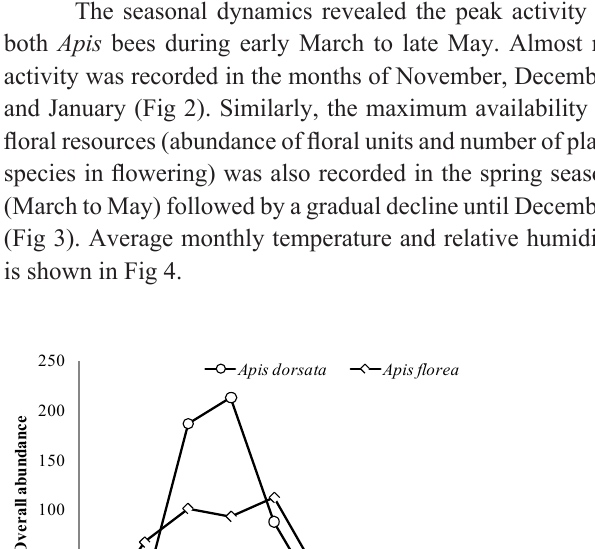
Fig 2 . Monthly abundance of A. dorsata and A. florea at Bahauddin Zakariya University Campus, Multan, Pakistan during January to December,